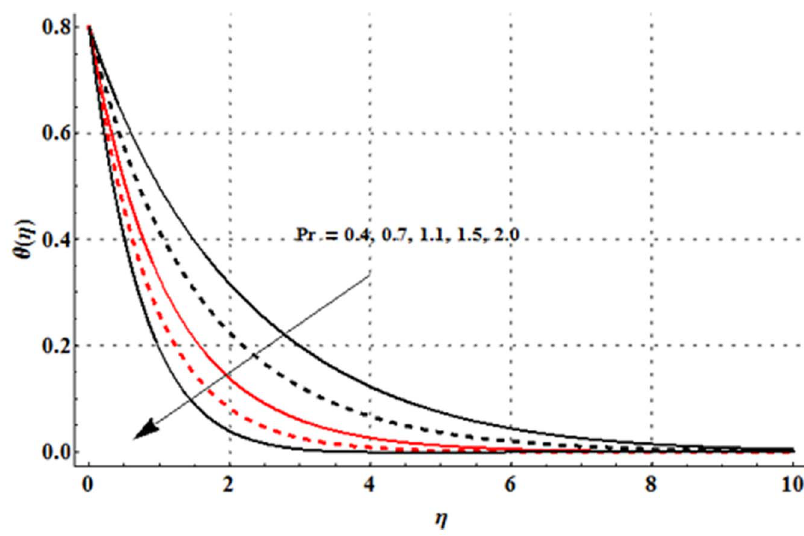
Figure 13. Influence of Pr on the temperature profile h ( g ) when M ~ 0 : 6, b ~ 0 : 4 ~ Rd , l 1 ~ 0 : 5, l ~ 0 : 3 ~ N , S ~ 0 : 2 ~ S (cid:2) and Sc ~ 1 : 0 :